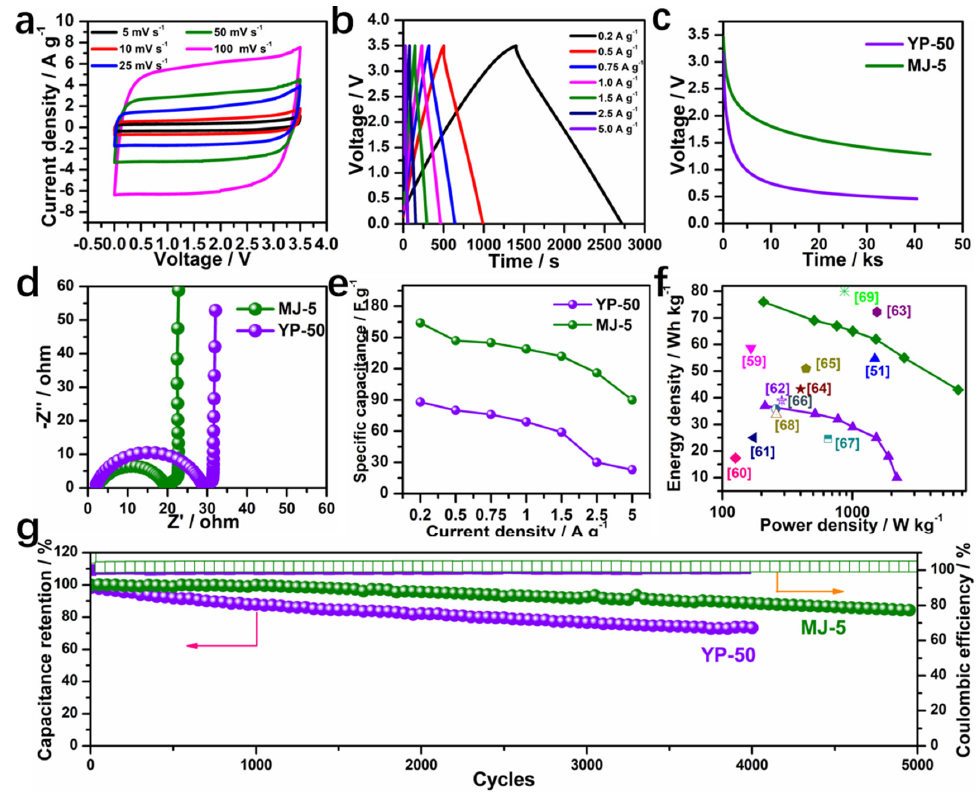
Figure 8. Electrochemical performance of MJ − 5 in an ionic liquid electrolyte. ( a ) CV curves of MJ − 5 from 5 mV s − 1 to 100 mV s − 1 ; ( b ) GCD plots of MJ − 5 from 0.2 A g − 1 to 5.0 A g − 1 ; Comparative